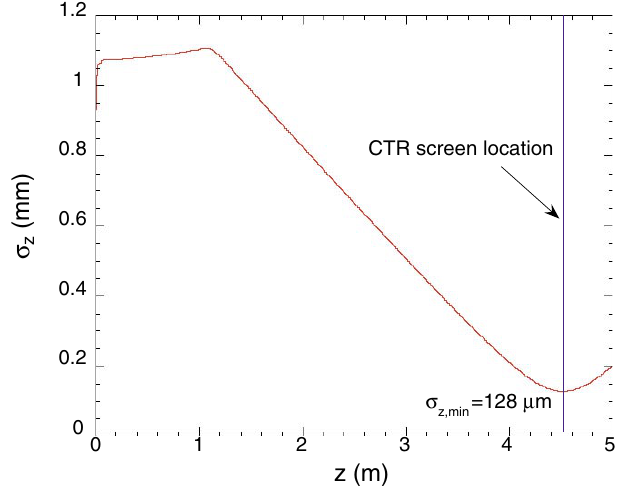
FIG. 11. (Color) Evolution of rms bunch length in Neptune ballistic bunching experiment, showing minimum of (cid:25) 128 (cid:4) m near CTR measurement screen location for experimen- tal conditions.